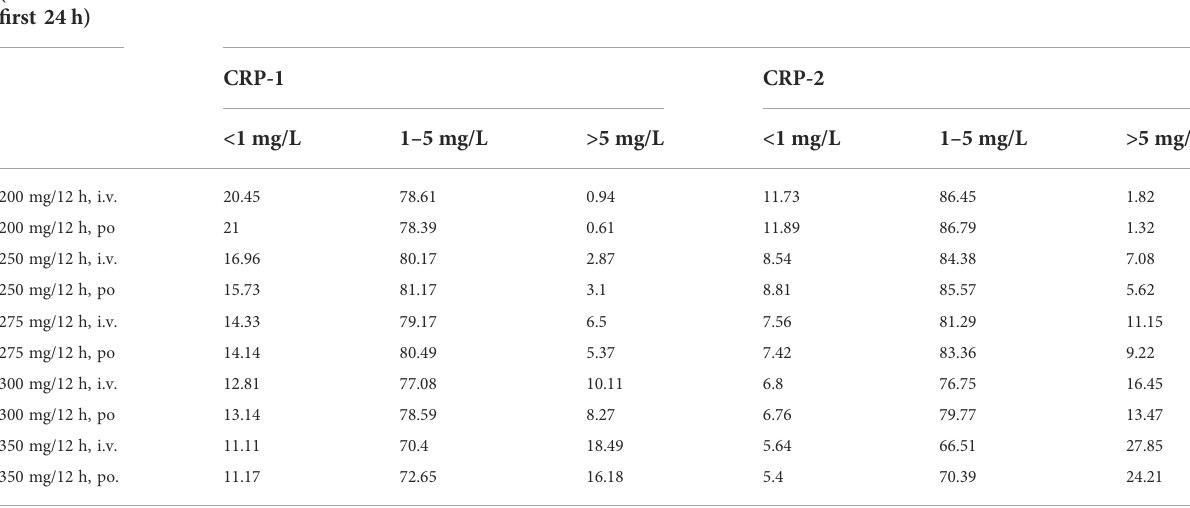
TABLE 3 Probability of C 24 reaching the treatment range in two groups with different voriconazole loading doses on the fi rst day. Loading dose (for the fi rst 24 h)